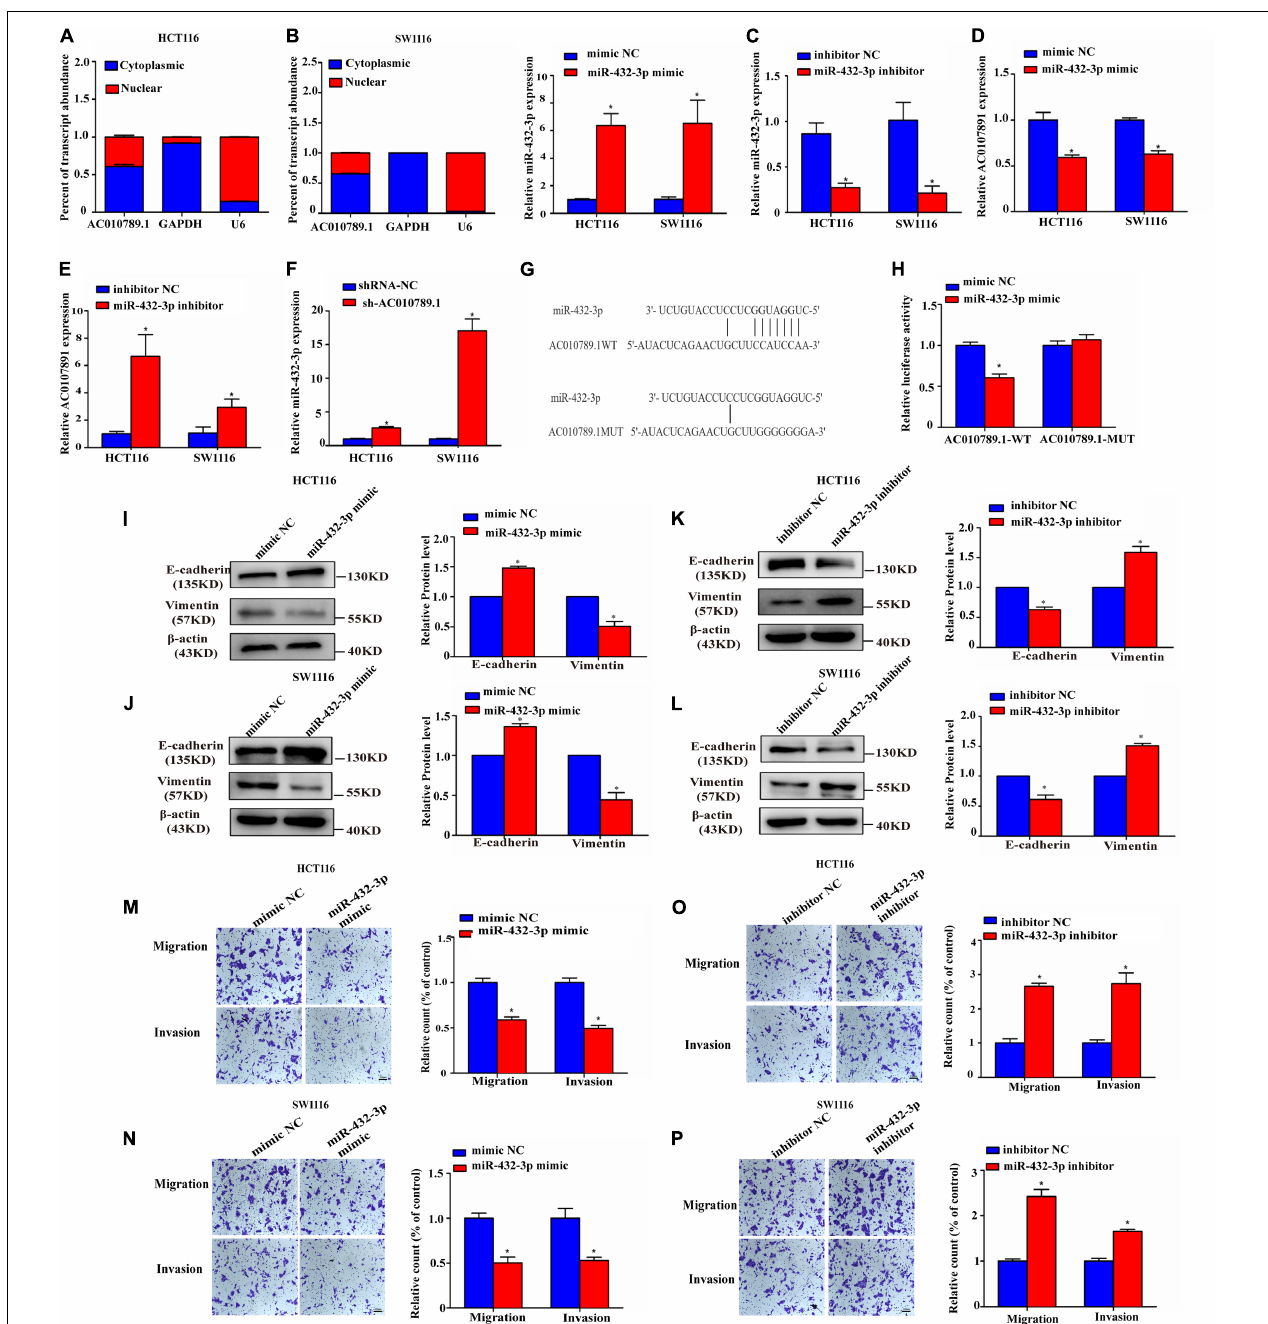
FIGURE 4 | MiR-432-3p directly binds to AC010789.1, producing an anti-tumor effect in CRC cells. (A) Level of AC010789.1 in the nuclear and cytoplasmic fractions of HCT116 and SW1116 cells. (B) Relative expression of miR-432-3p in HCT116 and SW1116 cells transfected with mimic NC or miR-432-3p mimic. (C) Relative expression of miR-432-3p in HCT116 and SW1116 cells transfected with inhibitor NC or miR-432-3p inhibitor. (D) Relative expression of AC010789.1 in HCT116 and SW1116 cells transfected with mimic NC or miR-432-3p mimic. (E) Relative expression of AC010789.1 in HCT116 and SW1116 cells transfected with inhibitor NC or miR-432-3p inhibitor. (F) Relative expression of miR-432-3p in HCT116 and SW1116 cells with stable shRNA-NC or sh-AC010789.1. (G) The schematic model showed the putative binding sites of miR-432-3p on AC010789.1. (H) Luciferase activity of AC010789.1-WT and AC010789.1-MUT reporter plasmid in HCT116 cells co-transfected with mimic NC or miR-432-3p mimic. (I,J) Expression levels of E-cadherin and vimentin were determined by western blot after transfection with mimic NC or miR-432-3p mimic in HCT116 and SW1116 cells. (K,L) Expression levels of E-cadherin and vimentin were determined by western blot after transfection with inhibitor NC or miR-432-3p inhibitor in HCT116 and SW1116 cells. (M,N) Transwell assay for investigating migration and invasion change after transfection with mimic NC or miR-432-3p mimic in HCT116 and SW1116 cells. (O,P) Transwell assay for investigating migration and invasion change after transfection with inhibitor NC or miR-432-3p inhibitor in HCT116 and SW1116 cells. Data are representative of three independent experiments and are presented as mean ± SEM. P -values were determined by two-tailed student’s t -test (* P < 0.05).